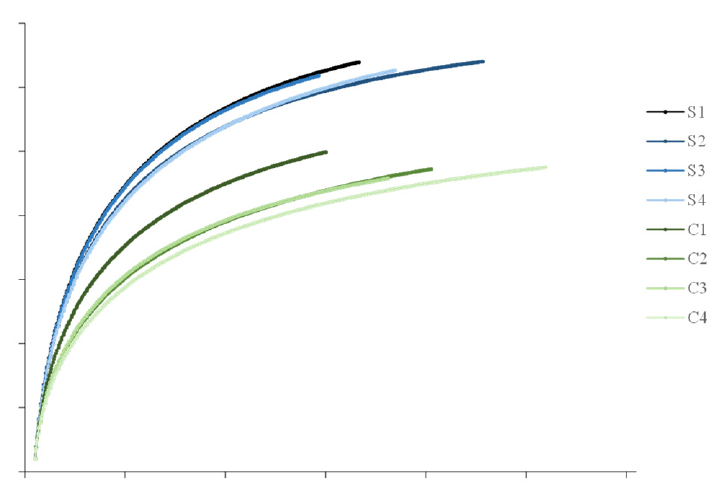
Figure 1. Rarefaction curves of the examined samples. The sequence similarity cut-off value in Mothur was 97%.